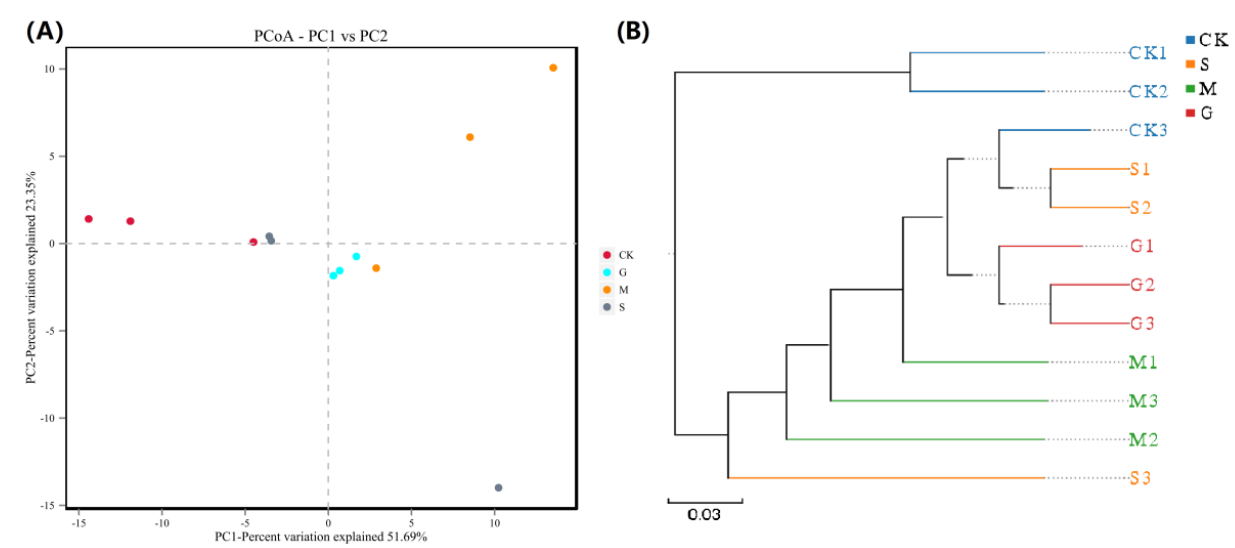
Figure 1. Venn analysis of OTUs and alpha-diversity of the bacterial community of stylo silage. ‘*’ and ‘**’ represent p < 0.05 and p < 0.01, respectively. CK, control; S, sucrose; G, glucose; M, molas- ses.( A ) OTUs number of the bacterial community of stylo silage; ( B ) Venn analysis of OTUs in the bacterial community of stylo silage; ( C – F ) the ACE, Chao1, Shannon and Simpson index of the bac- terial community of stylo silage, respectively.